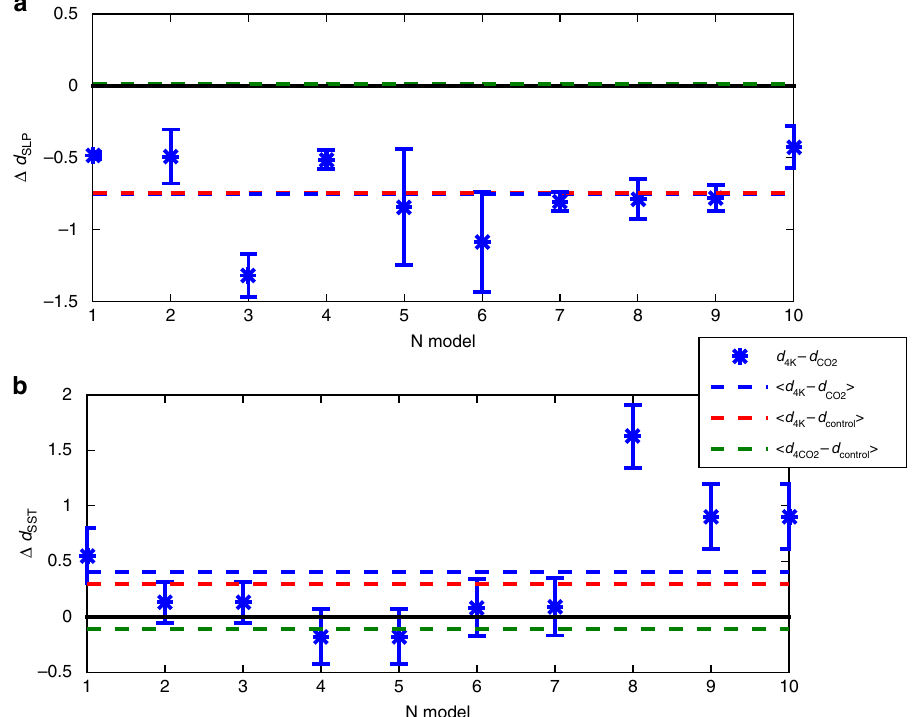
Fig. 2 Differences of local dimension in 4 × CO 2 and + 4 K Atmospheric Model Intercomparison Project (AMIP) simulations. Differences of Δ d between average local dimension d SLP for daily sea-level pressure (SLP) data ( a , b ) and d SST for monthly sea-surface temperature (SST) fi elds for the 4 × CO 2 and + 4 K AMIP simulations with respect to the control runs. Error bars indicate the standard deviation of the mean. Lines: means of the ensembles, indicated in the legend by angular